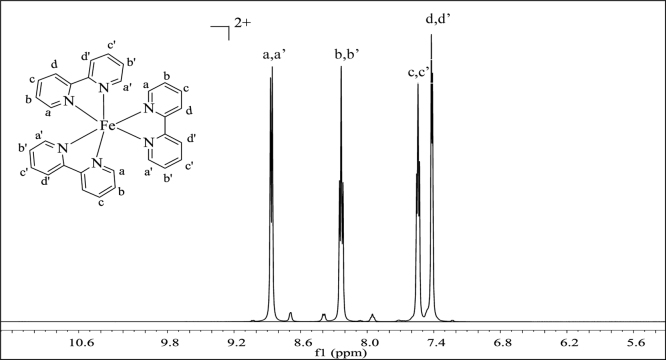
1H NMR spectrum (500 MHz) of complex 1 in dimethylsulfoxide-d6.